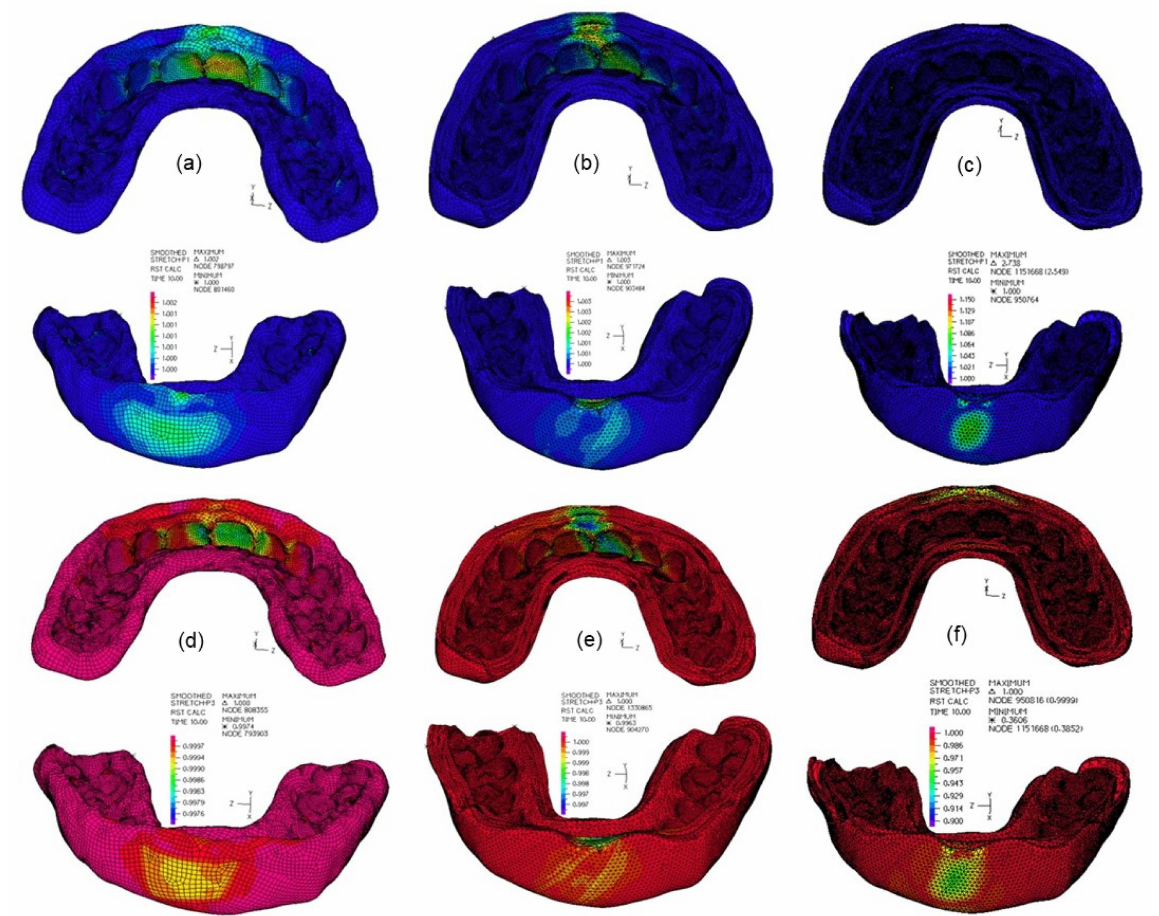
Figure 8. First principal stretches: ( a ) in the CMG; ( b ) in the FMG; ( c ) in the FMG. Third principal stretches: ( d ) in the CMG; ( e ) in the FMG; ( f ) in the HMG.